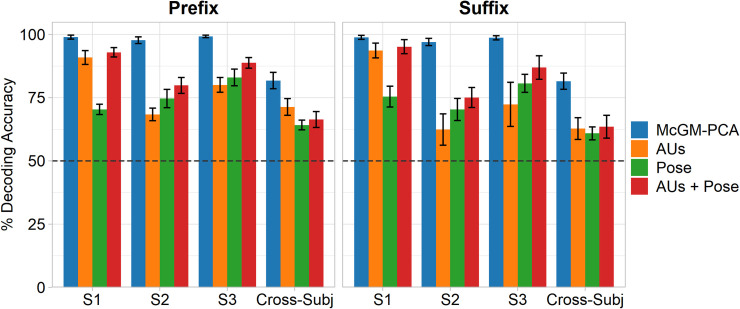
Summary of cross-validated classification accuracies.LDA classification accuracies for each model across subjects and for the cross-subject analyses. Values are averaged over cross-validation folds. Error bars indicate the standard error of the mean. The dashed line indicates the 50% chance level.